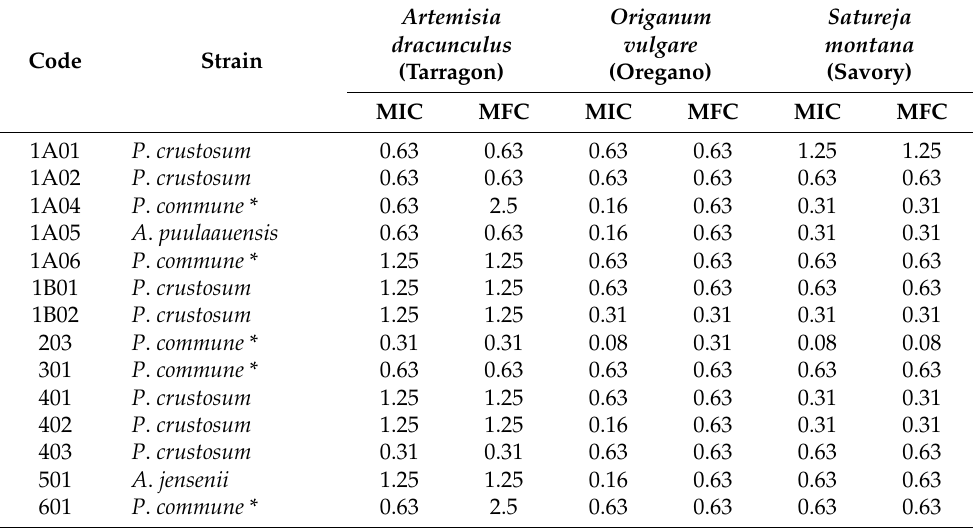
Table 5. Minimum inhibitory concentration (MIC) and minimum fungicidal concentration (MFC) of essential oils with antifungal activity expressed in mg/mL.